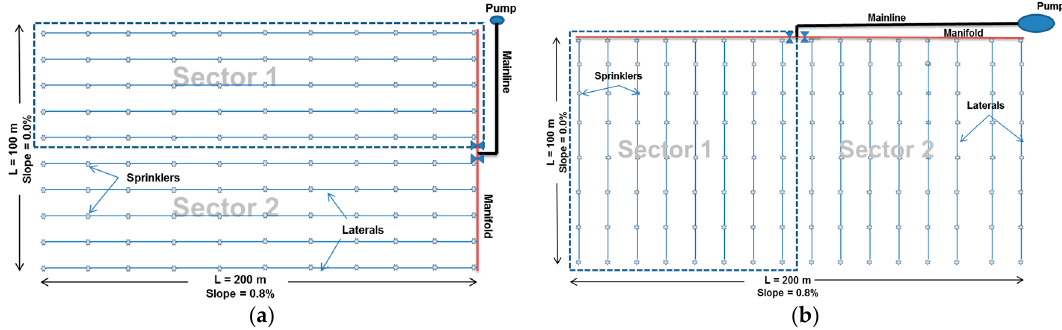
Figure 4 . Schematic drawing of two alternative pipe layouts. ( a ) Layout 1; ( b ) Layout 2. Table 1. Characteristics of sprinklers used for the various alternatives and respective application rate for various sprinkler spacing.